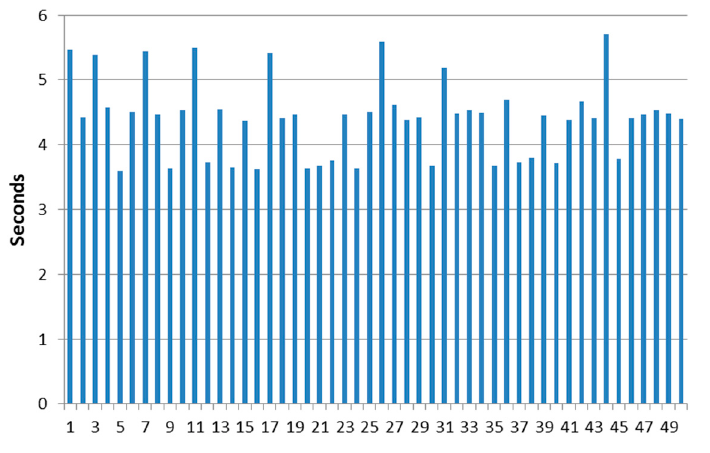
Figure 11. Time measurements for task executions.